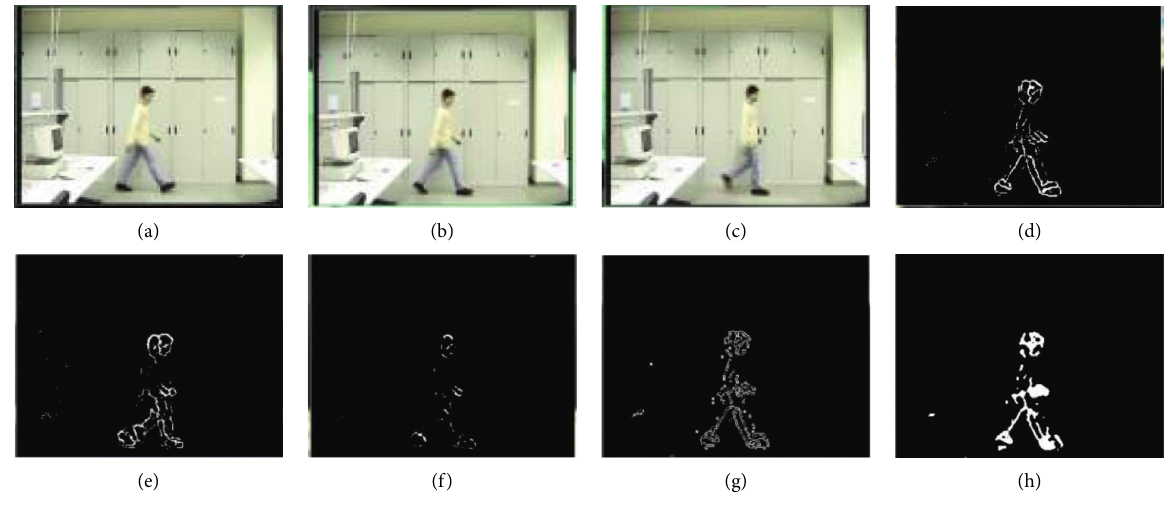
Figure 5: Experimental results of improved TFDM Table 1: Comparison of detection accuracy between TFDM and the improved TFDM algorithm.